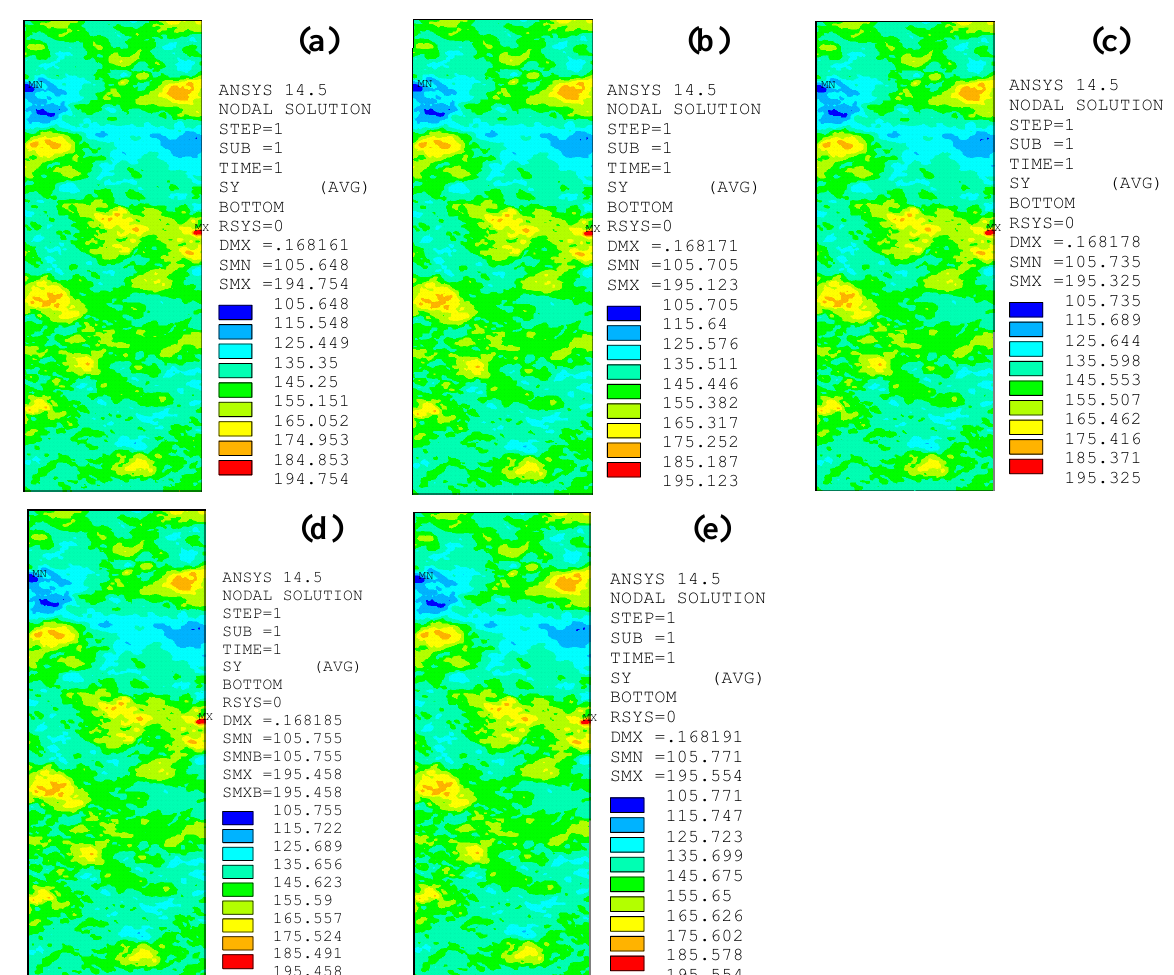
Figure 17. Peak tensile stress distribution on the corroded steel surfaces of the patched specimens with various adhesive thicknesses: ( a ) C18-DS1.0-A0.5, ( b ) C18-DS1.0-A1.0, ( c ) C18-DS1.0-A1.5, ( d )